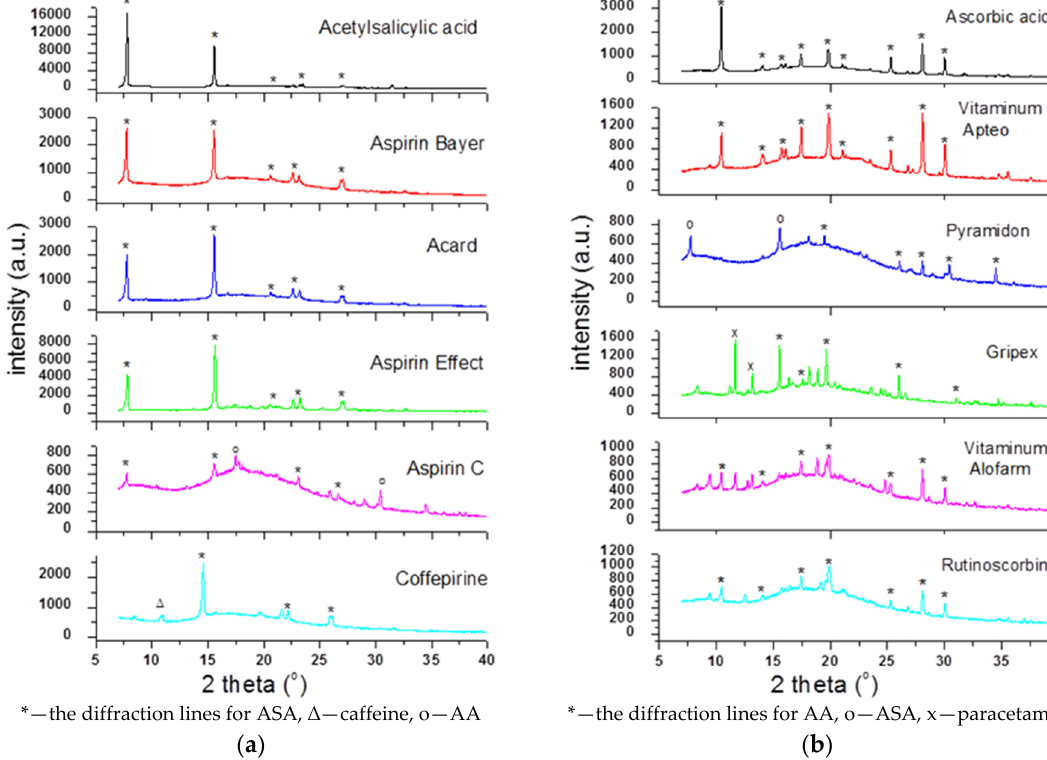
Figure 11. Diffraction patterns for drugs containing ( a ) acetylsalicylic acid (ASA); ( b ) ascorbic acid (AA).